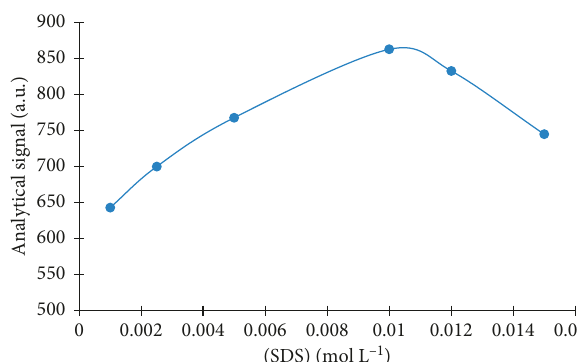
Figure 1: Effect of sodium dodecyl sulfate on the analytical signal for 10mg · L − 1